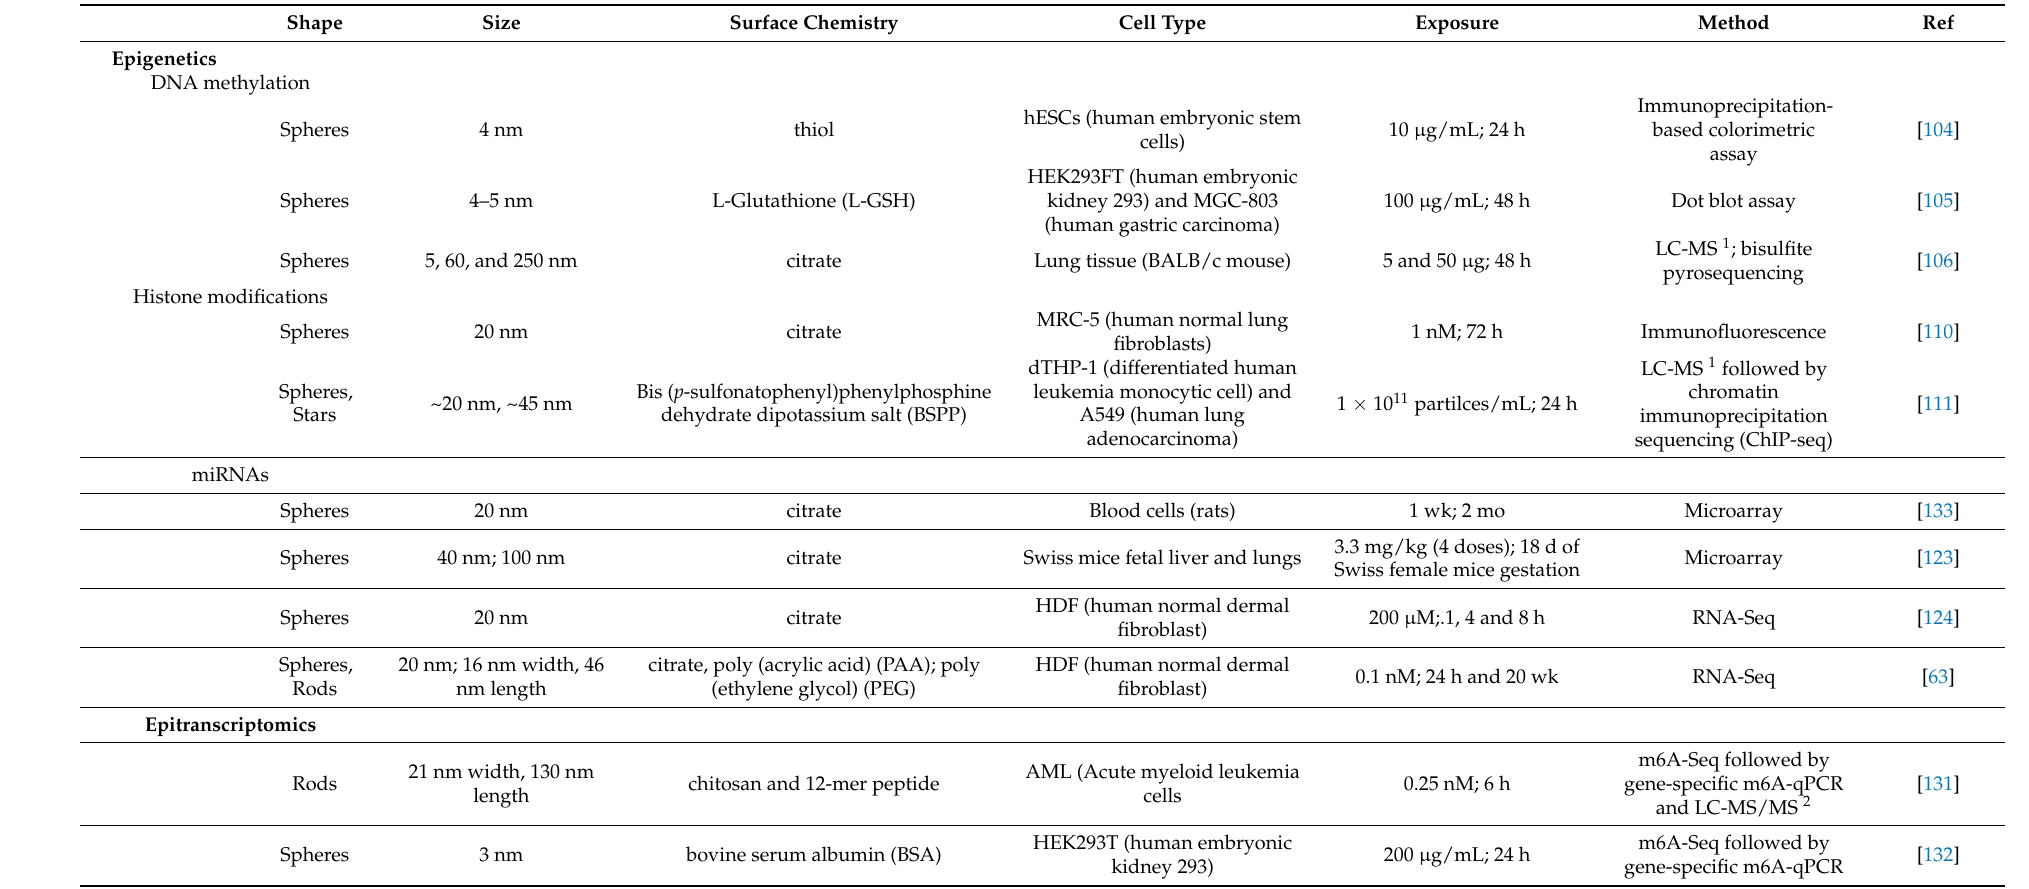
Table 5. Examples of epigenetic and epitranscriptomic changes induced by AuNPs in